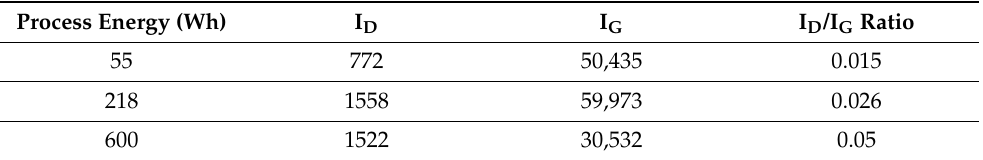
Figure 2. ( a ) Optical absorbance density of SWCNT dispersion samples in 273 nm dependent on the process energy. Optical microscopy images are presented for 3 process points: 27 Wh (beginning of the process), 109 Wh (middle), and 218 Wh (end of process). The scale bar in the images is 100 µ m. ( b ) Resonance ratio and spectral width of the 273 nm peak dependent on the process energy. Table 1. Intensity of G and D Raman peaks for 3 points along the SWCNT dispersion process and I D /I G ratio